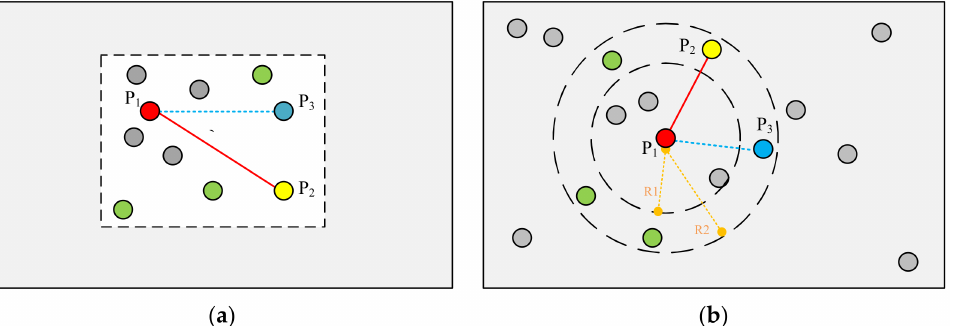
Figure 3. Feature baseline extraction: ( a ) feature baseline extraction in Level 2; ( b ) feature baseline extraction in Level